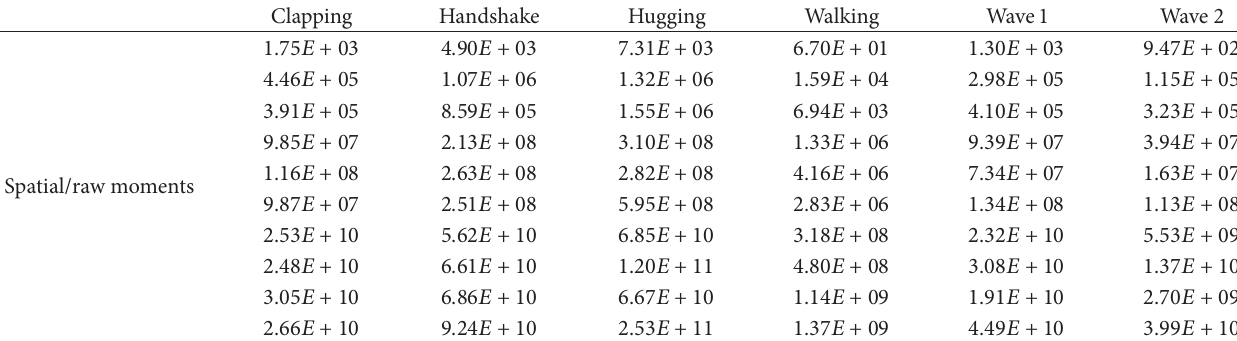
Table 1: The numerical comparison of raw moments for each of the actions. Clapping Handshake Hugging Walking Wave 1 Wave 2 1.75𝐸 + 03 4.90𝐸 +